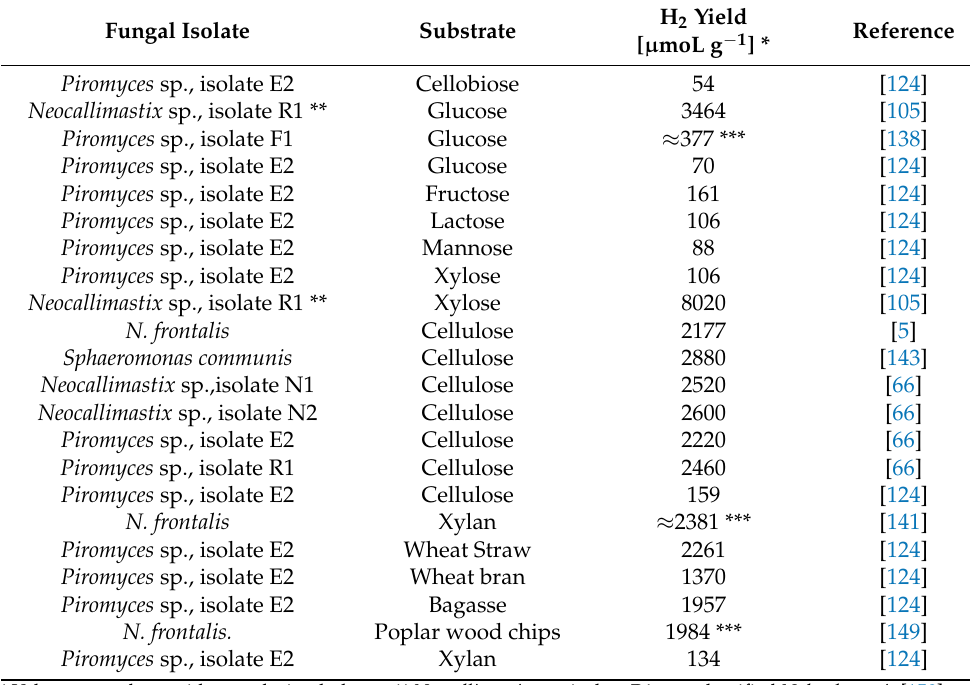
Table 2. Anaerobic fungal H 2 yields from dark